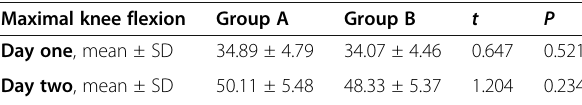
Table 3 Comparison between the two groups regarding Table 5 Comparison between the two groups regarding morphine consumption during the 48 h from operation maximal knee flexion at day one and day two from Group A Group B